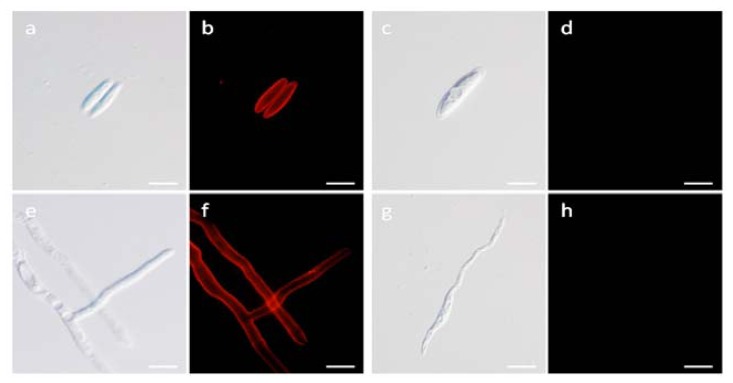
Photomicrographs of Fusarium verticillioides immunostained with FvCA4 antibody. (a) and (c), conidiospores of F. verticillioides examined under a bright-field microscope; (e) and (g), hyphae of F. verticillioides examined under a bright-field microscope; (b) and (f), the same slides shown in panel (a) and (e) were examined under Cy3 with FvCA4 antibody; (d) and (h), the same slides shown in panel (c) and (g) were examined under Cy3 with PIPP antibody. Bar, 10 μm.